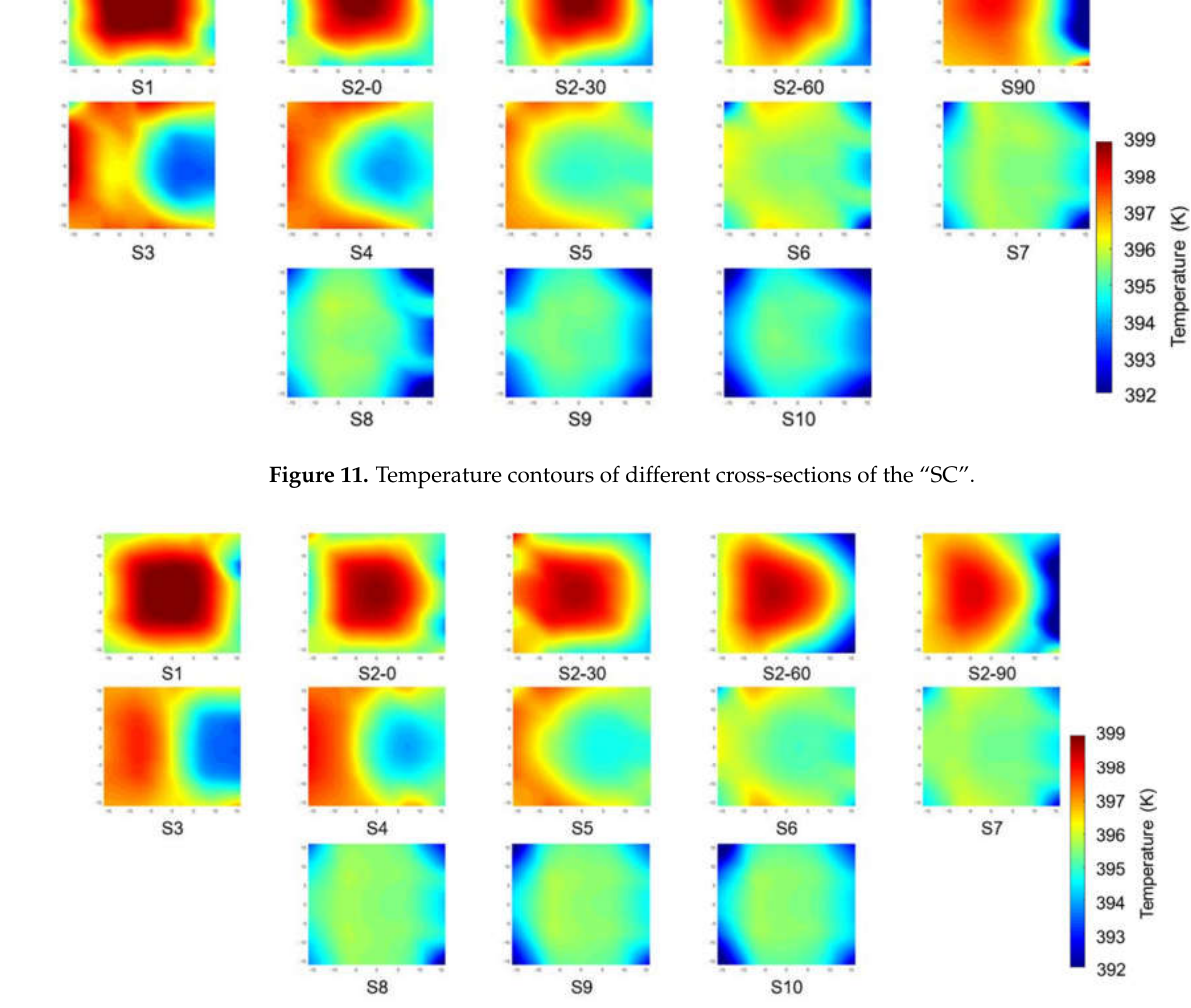
Figure 12. Temperature contours of different cross-sections of the “SC”.